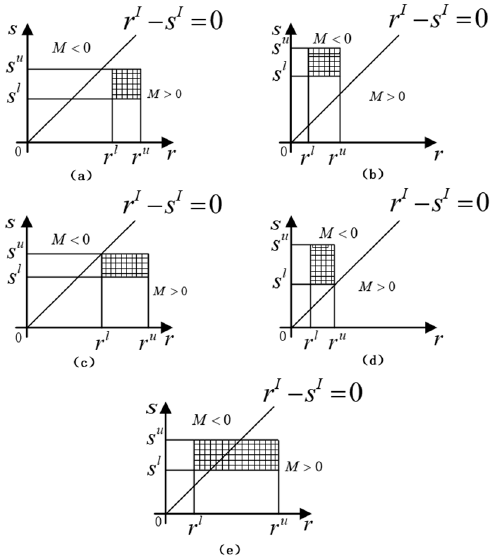
Figure 4. Interference model for robot end-effector position error and allowable accuracy.